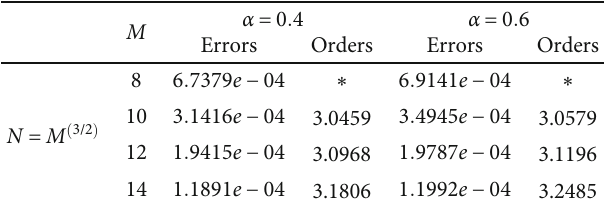
Table 3: The errors and convergence orders in spatial direction by using Q-FEM.